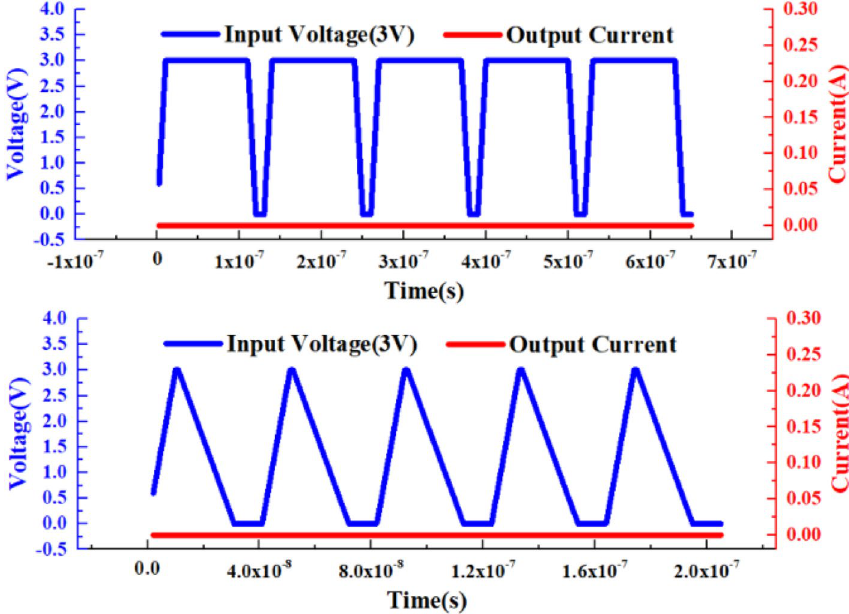
Figure 2. VADTS simulation voltage–time curve and simulation current–time curve (3